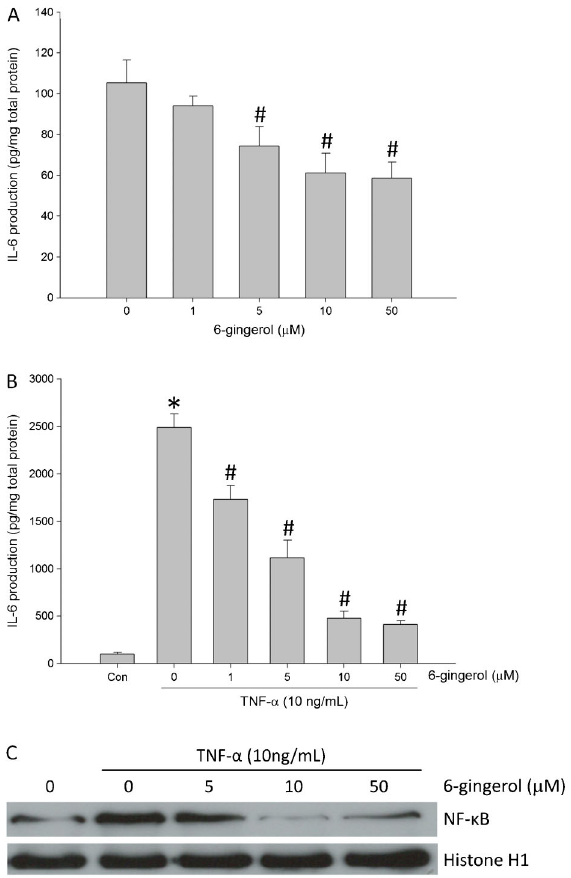
Figure 6. 6-Gingerol suppressed interleukin (IL)-6 in MG-63 cells treated without ( A ) or with ( B ) tumor necrosis factor (TNF)- a stimulation. Cells were treated with serial concentrations of 6- gingerol (0-50 m M) for 48 h and IL-6 production was determined by ELISA. C , Nuclear translocation of nuclear factor (NF)- k B upon TNF- a stimulation was examined using immunoblotting. Data are reported as means±SE for 3 independent experiments. # P , 0.05 compared to 0 m M; *P , 0.05 compared to control (Con) (Student’s t